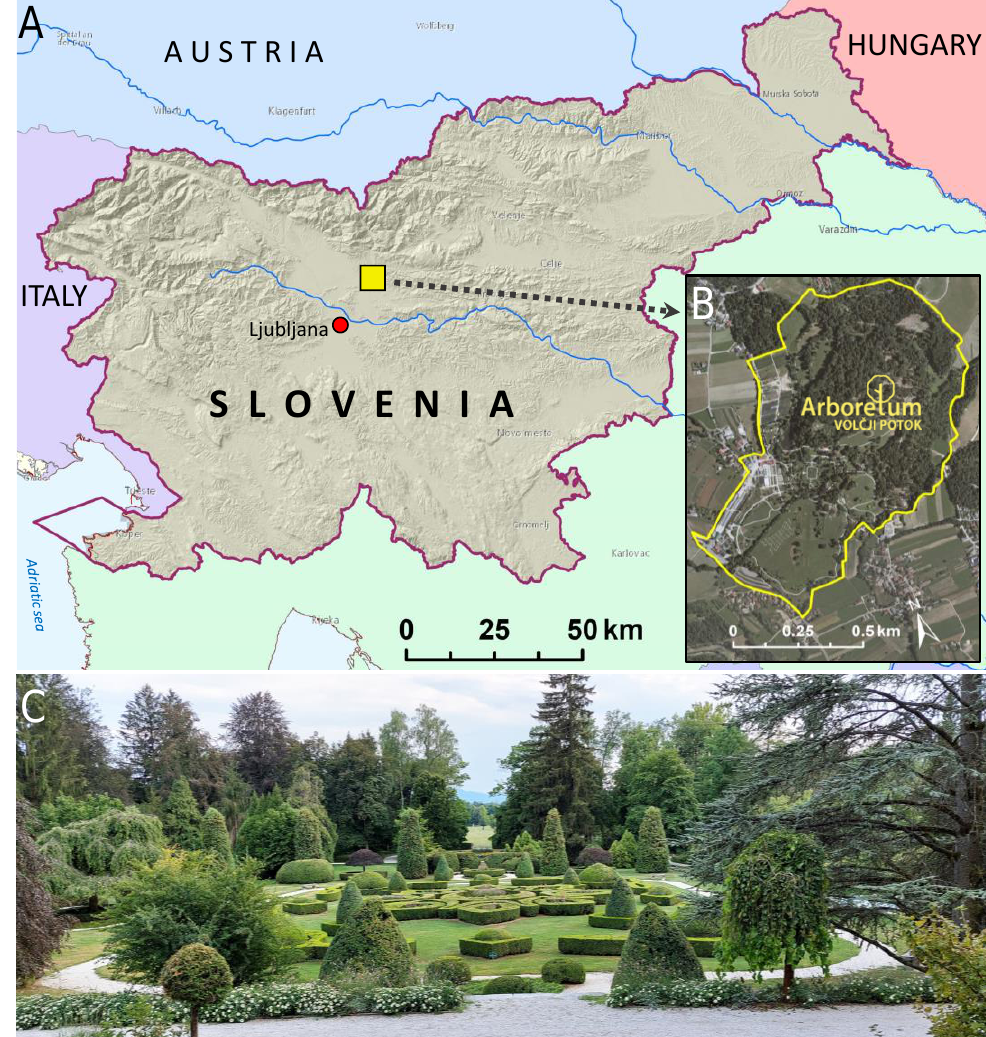
Figure 1. Geographical situation of the Volčji Potok Arboretum in Slovenia ( A , B ); ( C ) one of examined woody plant collections. Photo: S. Gomboc. The maps were produced using ArcGIS Pro software and country layers [29–31].